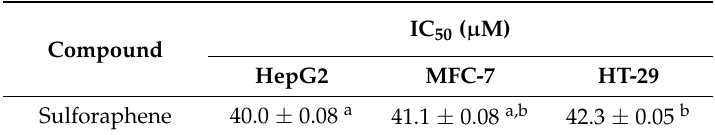
Table 2. Cytotoxicity of sulforaphene in HepG2, MCF-7 and HT-29 cells. Compound